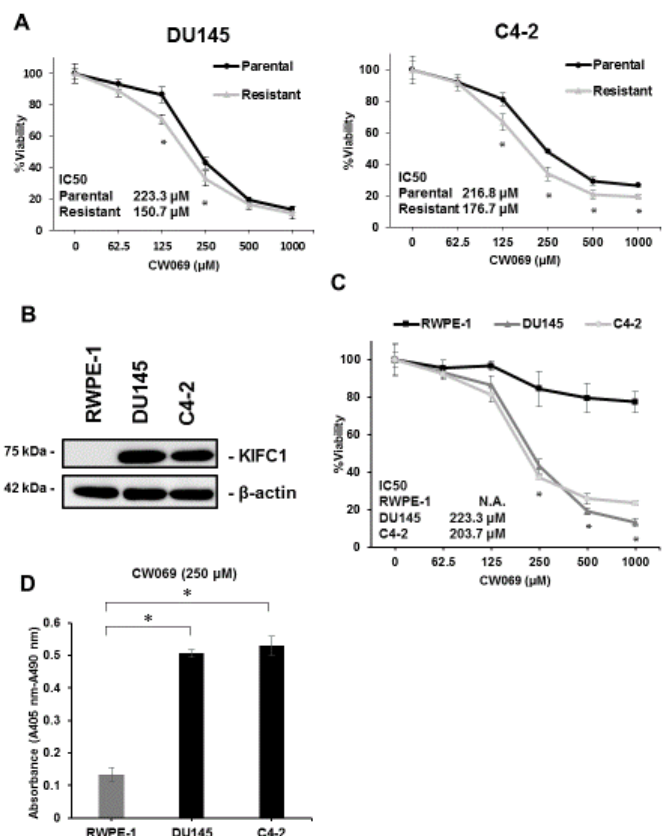
Figure 4. The effect of the KIFC1 inhibitor CW069 on cell viability ( A ) The dose-dependent effects of CW069 on cell viability in parental and docetaxel-resistant cell lines in DU145 and C4-2 cells. The results are expressed as the mean and S.D. of triplicate measurements. * p < 0.01. ( B ) Western blotting of KIFC1 in RWPE-1, DU145, and C4-2 cells. ( C ) The dose-dependent effects of CW069 on cell viability in RWPE-1, DU145, and C4-2 cells. The results are expressed as the mean and S.D. of triplicate measurements. * p < 0.01. ( D ) The cell death ELISA in RWPE-1, DU145, and C4-2 cells treated with CW069 (250 μM). The results are expressed as the mean and S.D. of triplicate measurements. * p < 0.01.